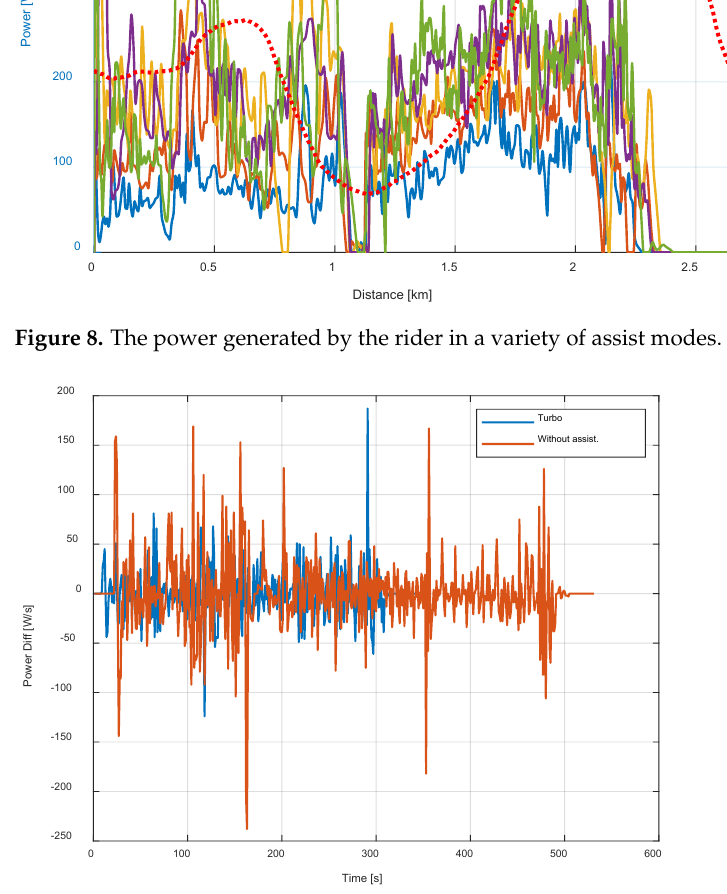
Figure 9. Change in the power value in subsequent moments of the sampling time.